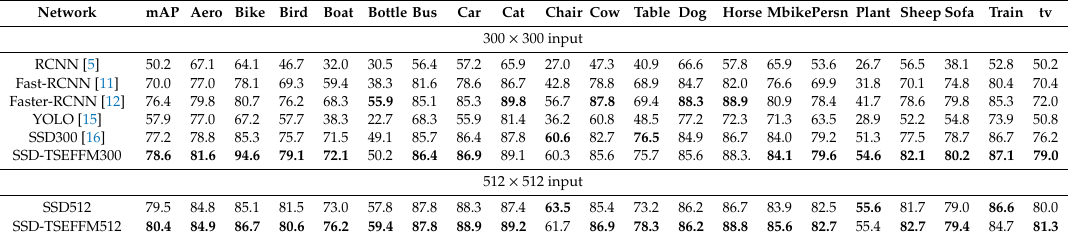
Table 1. Average precision results tested on Pascal VOC 2007 dataset (Bold values indicate the maxima). Network